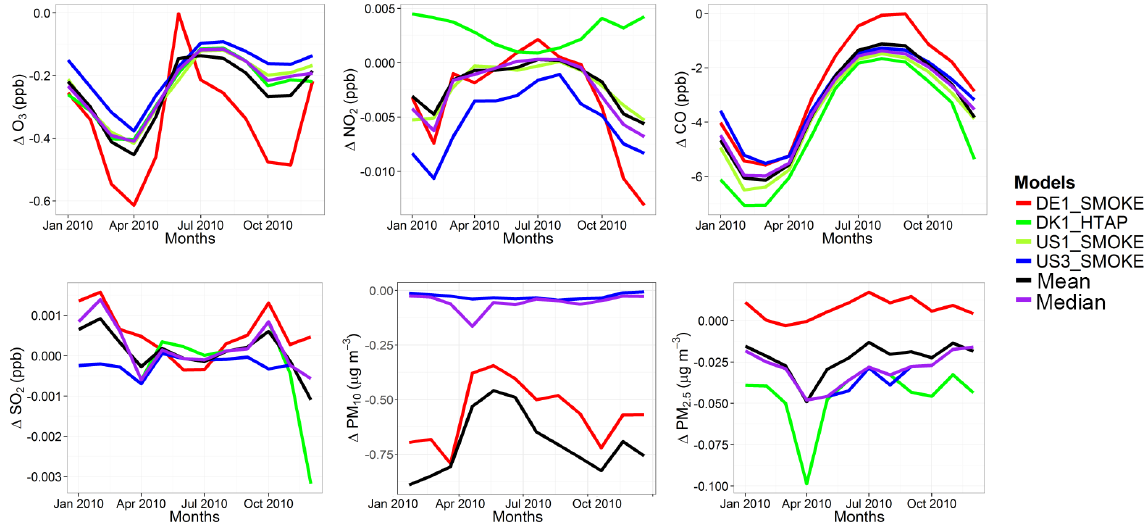
Figure 15. Absolute impact of the 20% reduction of the East Asian anthropogenic emissions over North America (GLO NAM − BASE NAM ).